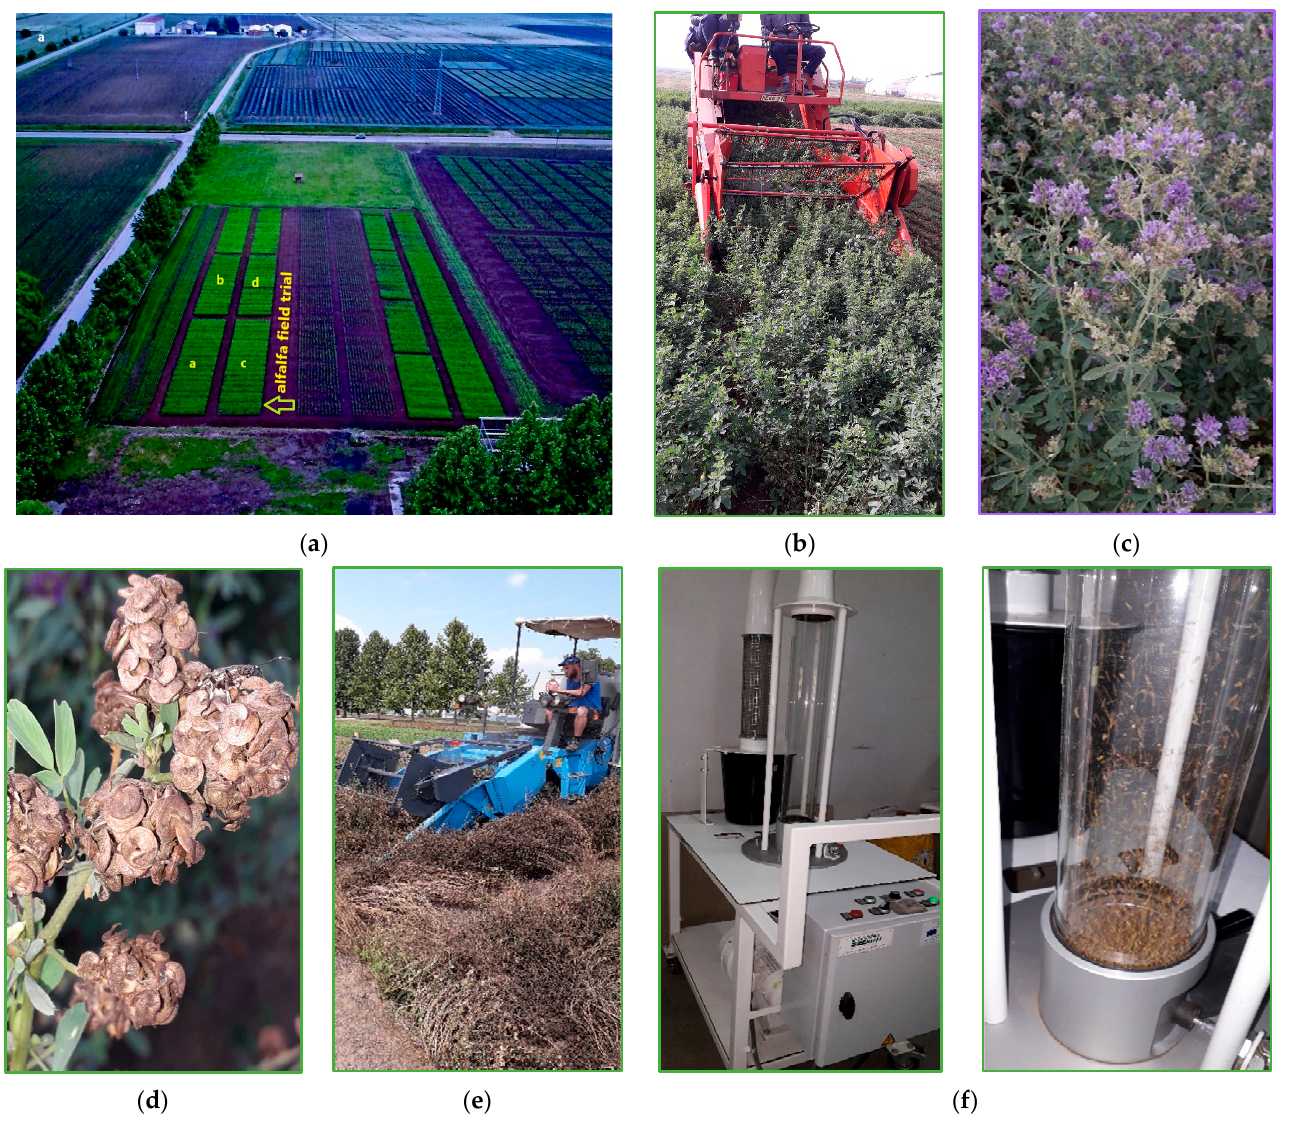
Figure 1. Assessment of alfalfa experimental populations on the selection field at the Agricultural Institute Osijek during the five-year (2014–2018) study: ( a ) established field trial plots; ( b ) cutting of green forage; ( c ) alfalfa in the full flowering stage; ( d ) matured brown pods; ( e ) seed harvest; ( f ) seed cleaning after the harvesting.